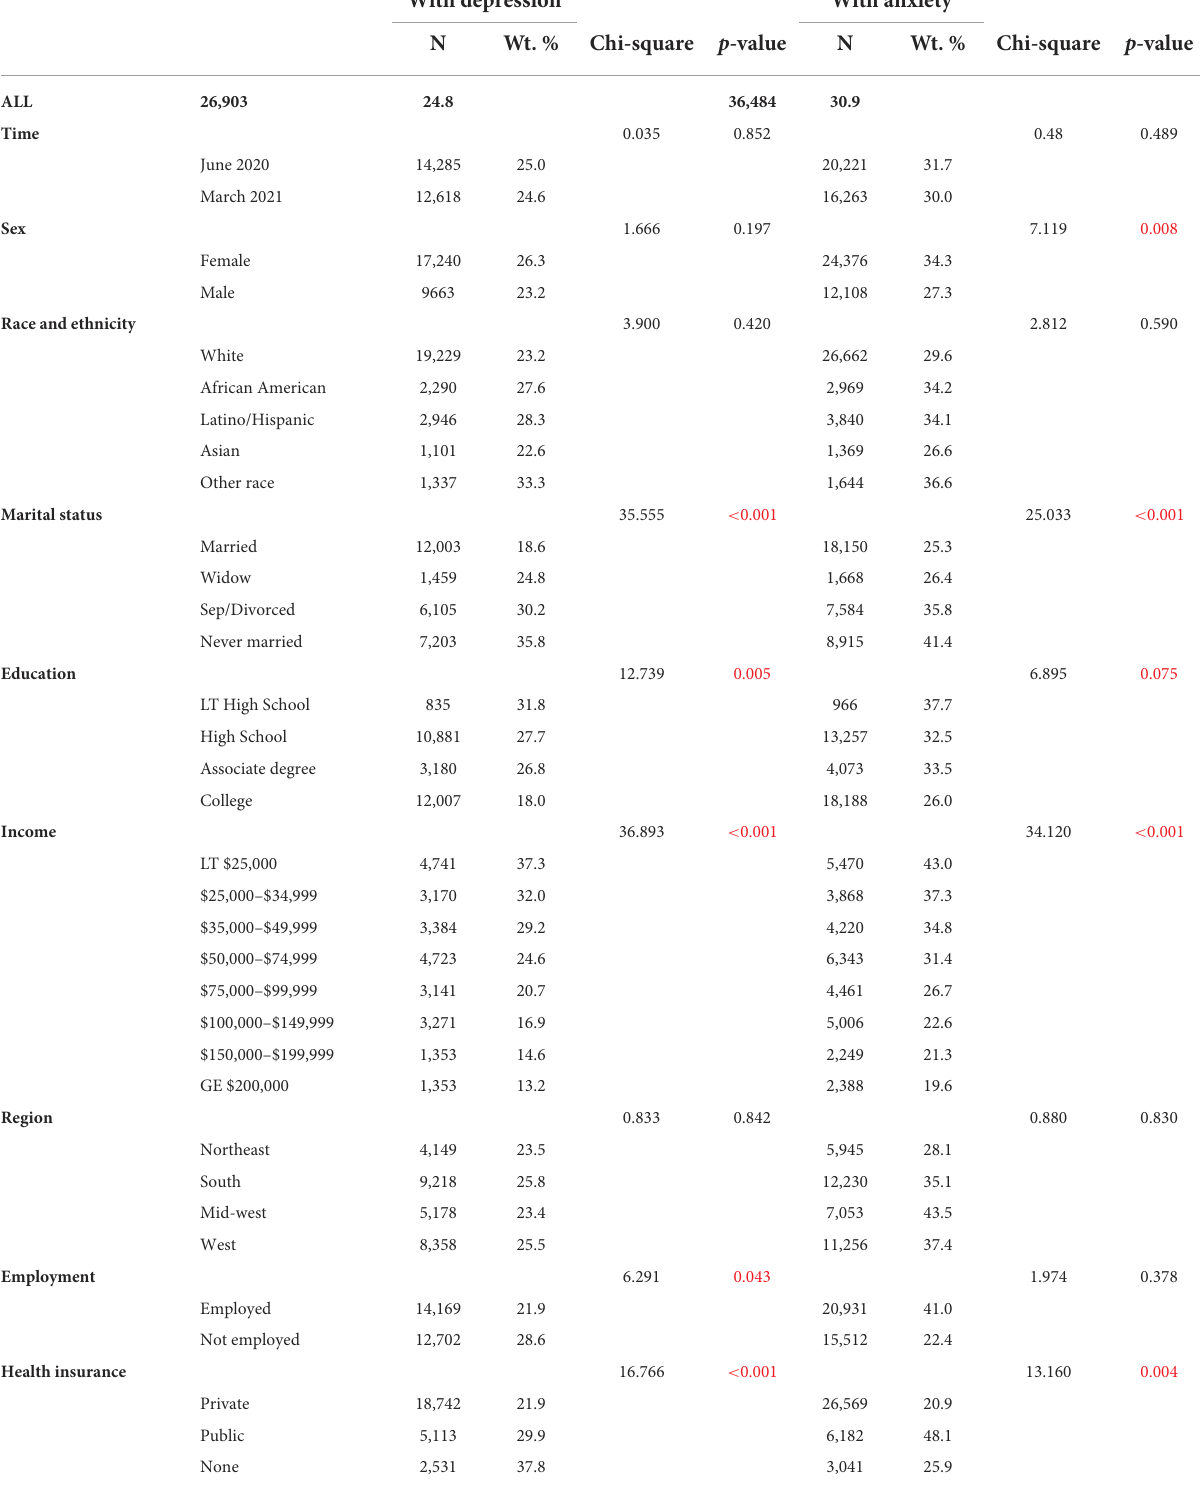
TABLE 2 Description of selected characteristics of adult respondents by depression and anxiety (row percentages) United States Census Pulse Survey–week 7 (june 2020) and week 27 (march 2021). With depression With anxiety N Wt. % Chi-square p -value N Wt. % Chi-square p